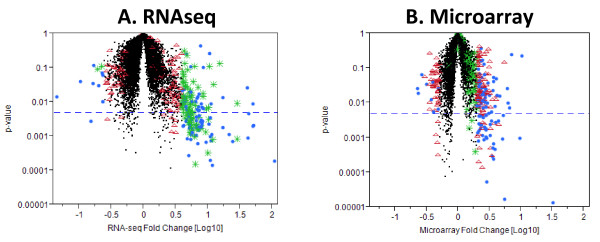
Volcano plots for RNA-seq and Exon array. (A). p-value vs. log10 fold change (SCD vs. control) for RNA-seq data.(B). p-value vs. log10 fold change for Affymetrix human Exon array data. Points in the lower right and lower left hand corners of the plots represent transcript clusters that are significant and differentially expressed. ●Blue circles represent transcripts with a FC greater or equal to 4 in RNA-seq and Δ Red triangles represent FC greater or equal to 2 in Exon arrays. *Green asterisks represent transcripts with a FC greater than or equal to 4 on RNA-seq only.